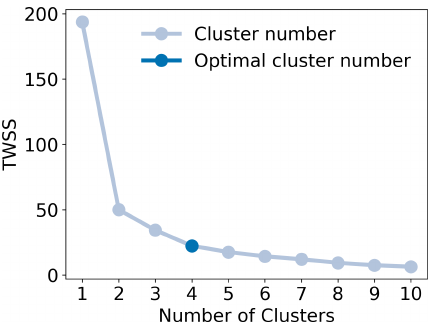
Figure 5. Elbow plot for k -means clustering with automated com- pound selection for the PC1 and PC2 pair. The dark blue marker indicates the optimum number of clusters.